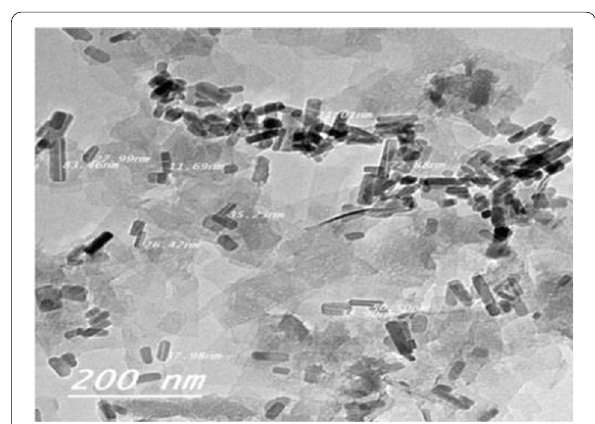
Fig. 5 TEM photomicrograph of the prepared